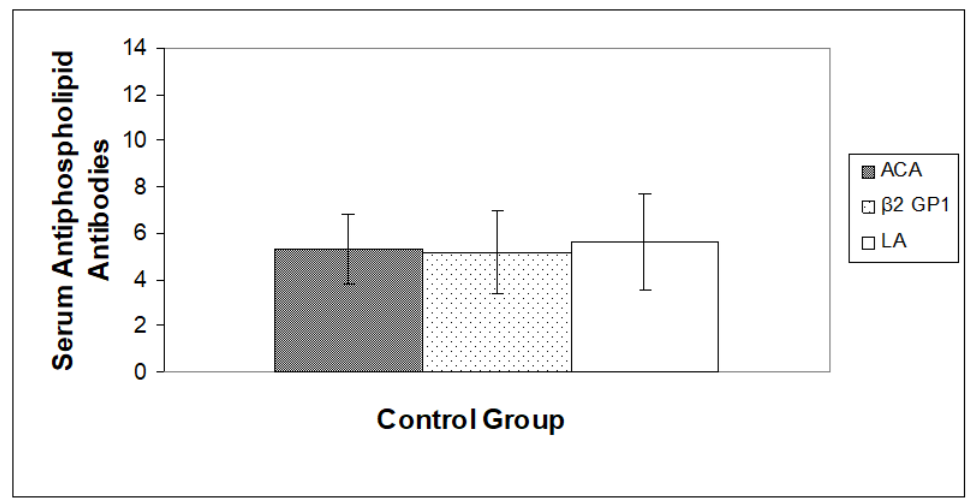
Figure 1. Estimation of anticardiolipin (ACA), anti- β2 -glycoprotein- 1 (β2 GP1) and Lupus anticoagulants (LA) in the control group of Saudi women. Values are Mean ± SD, ( n = 100), n = Total number of subject examinations.